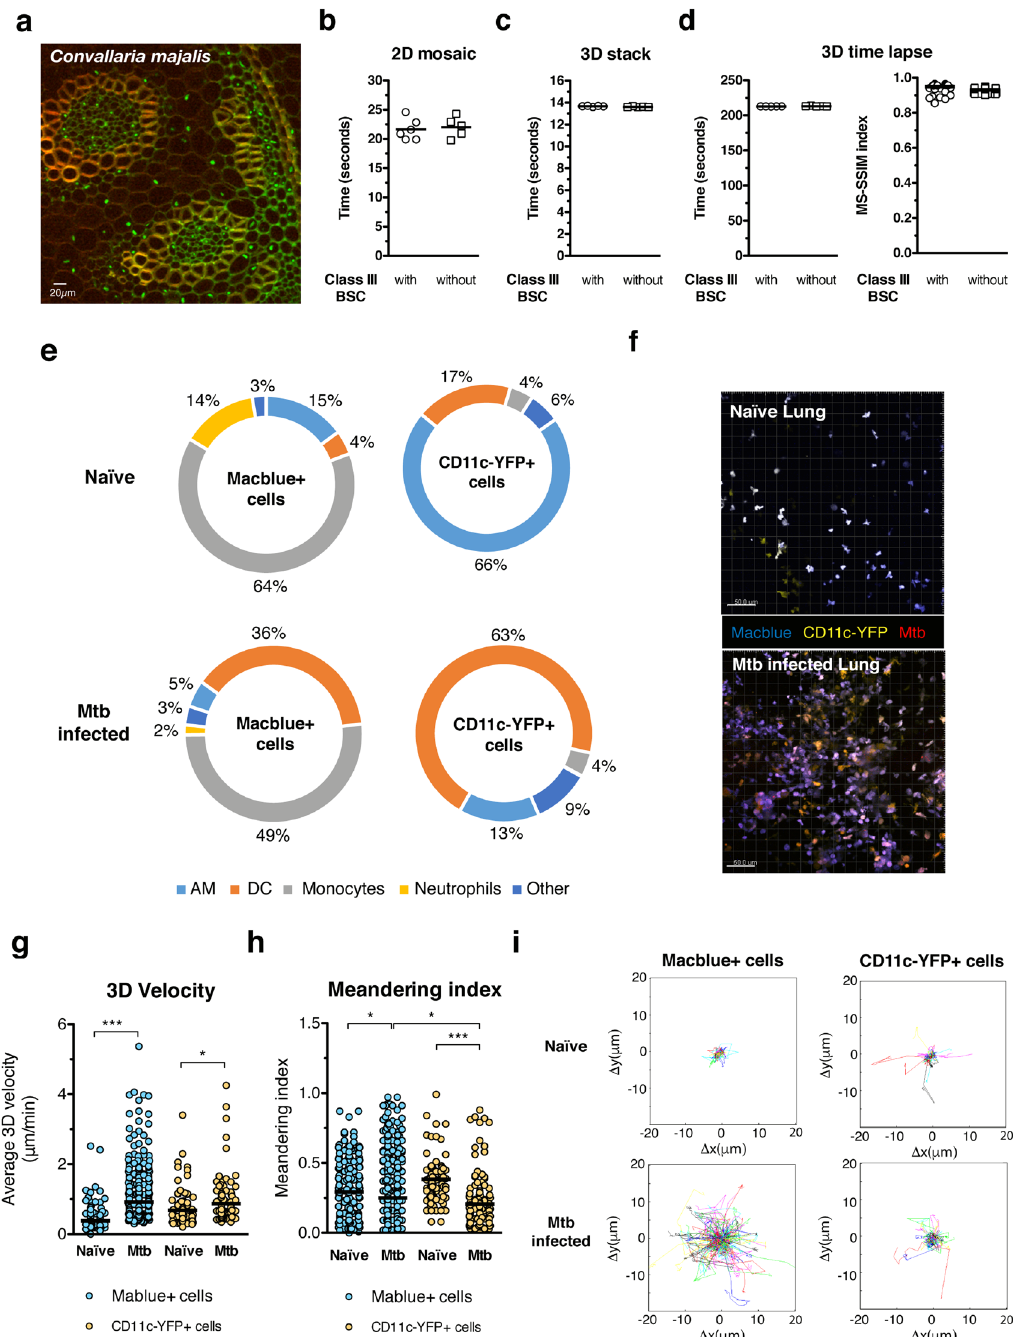
Figure 3. BSL3 setup for multiphoton microscopy: performance and applications. ( a ) A Convallaria majalis rhizome slide was used to evaluate the performance of the multiphoton microscope with and without the class III BSC installed. For this images with a size of 505 * 505 pixels were acquired with 3% of Ti-Saphire laser power tuned to 800 nm and with a pixel dwell time of 2,78 μ s. These images were acquired either in 9 different x, y axis positions using the mosaic function ( b ), 13 different z axis positions with a step of 2 μ m using the 3D stack function ( c ) and 13 z axis positions repeated overtime 15 times ( d ). Performance of x, y and z axis movement of the microscope was evaluated by recording the time necessary for completion of the different tasks. To quantify image stability overtime we calculated the Structural SIMilarity (SSIM) index between the first 3D stack and each of the subsequent ones within the same time-lapse sequence. Acquisition speed and stability values were calculated from 5 different acquisitions. ( e ) Flow cytometry analysis of naïve and M . tuberculosis (Mtb) (H37Rv) mouse lung according to the expression of Macblue and CD11c-YFP transgene. ( f ) Maximum intensity projection of a 3D stack from a naïve and Mtb infected lung vibratome slice. 3D velocity ( g ), meandering index ( h ) and Cell Tracks ( i ) of Macblue + and CD11c-YFP + lung cells in vibratome slices. Cell motility parameters were calculated in movies from 3 different areas of lung. Un paired t test was used to evaluate significant differences. * p < 0,05, ** p < 0,01, *** p <